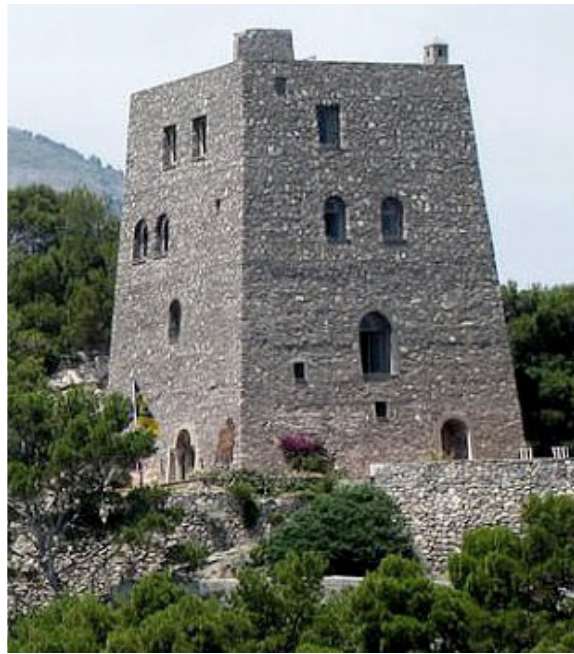
Figure 5 Isola Lunga de Li Galli Tower. (Diaz,